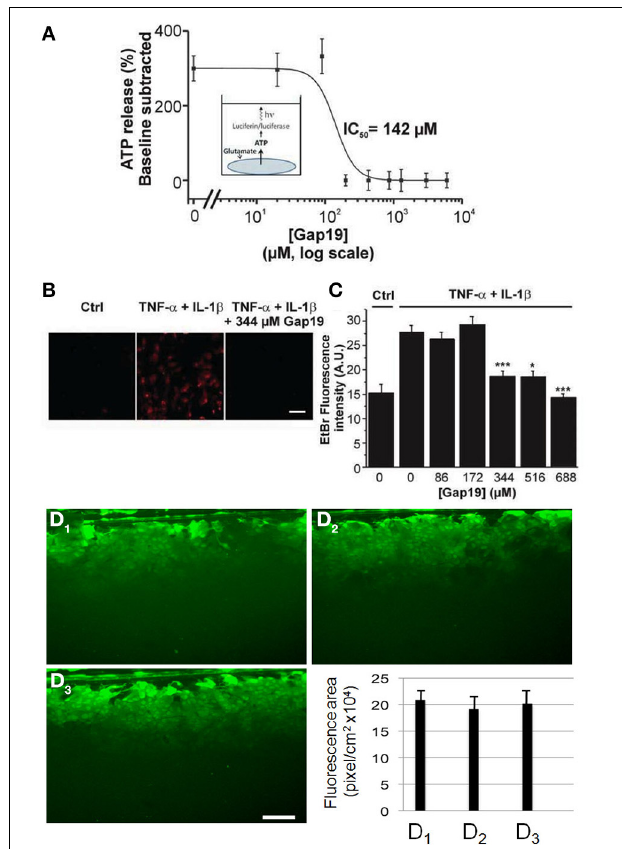
FIGURE 2 | Dose-dependent inhibition of ATP release and Etd + uptake through Cx43 hemichannels by Gap19 with lack of effect on gap junctional communication in cultured astrocytes. (A) Concentration-dependent inhibition by Gap19 (30min pre-incubation) of ATP release in cultured cortical astrocytes triggered by glutamate (100 μ M, 15min application) ( n = 6 independent experiments). (B) Representative images showing Etd + uptake (red) in cultured astrocytes under control conditions (Ctrl) and after TNF- α /IL-1 β or TNF- α /IL-1 β + Gap19 treatment. Scale bar: 20 μ m. ( ∗ p < 0 . 05; ∗∗∗ p < 0 . 001). (C) Summary data of Etd + uptake studies in astrocytes, demonstrating inhibition by Gap19 ( n = 5–8 independent experiments). Statistical comparisons refer to the stimulus condition without Gap19 (zero Gap19 concentration). (D 1 –D 3 ) Representative images of scrape-loading dye transfer experiment in confluent cultures of astrocytes. Compared to control condition (D 1 ) , with Gap19 344 μ M ( D 2 , 30min pre-incubation) or 688 μ M ( D 3 , 30min pre-incubation). Lower graph: Quantification of scrape-loading data indicating that Gap19 did not influence gap junctional coupling as measured in confluent cultures of astrocytes (from left to right, bars are from control and the two tested concentrations of Gap19, respectively). ( n = 3–5 independent